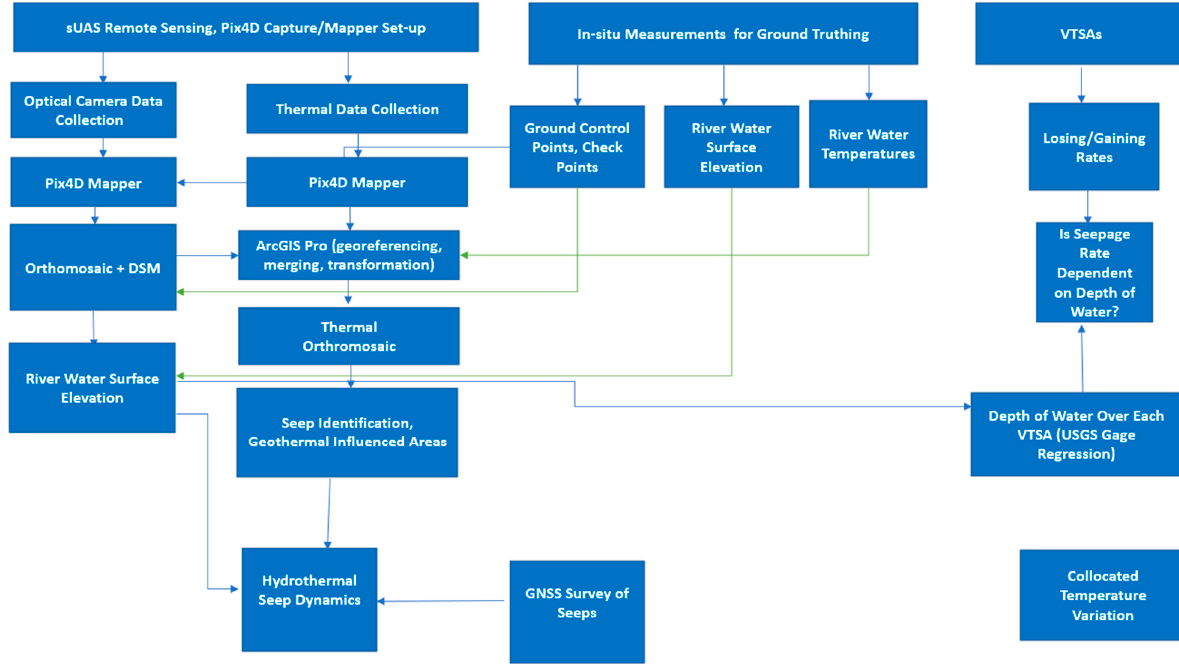
Figure 2. Overview of the data collection and processing workflow. Green lines represent remote sensing data accuracy verification using ground truthing data.